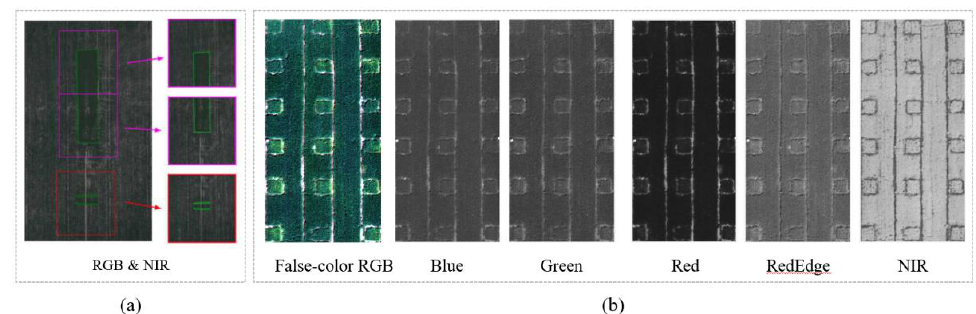
Figure 3. Examples of existing datasets for agriculture sensing at the field scale. ( a ) Agriculture-Vision (94,986 images) [125]. ( b ) Wheat Yellow Rust dataset [126].